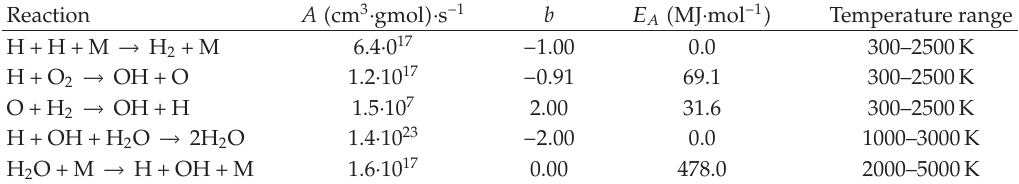
Table 1: Empirical values for reactions in the combustion of hydrogen with air (cid:5) 24 (cid:6) .